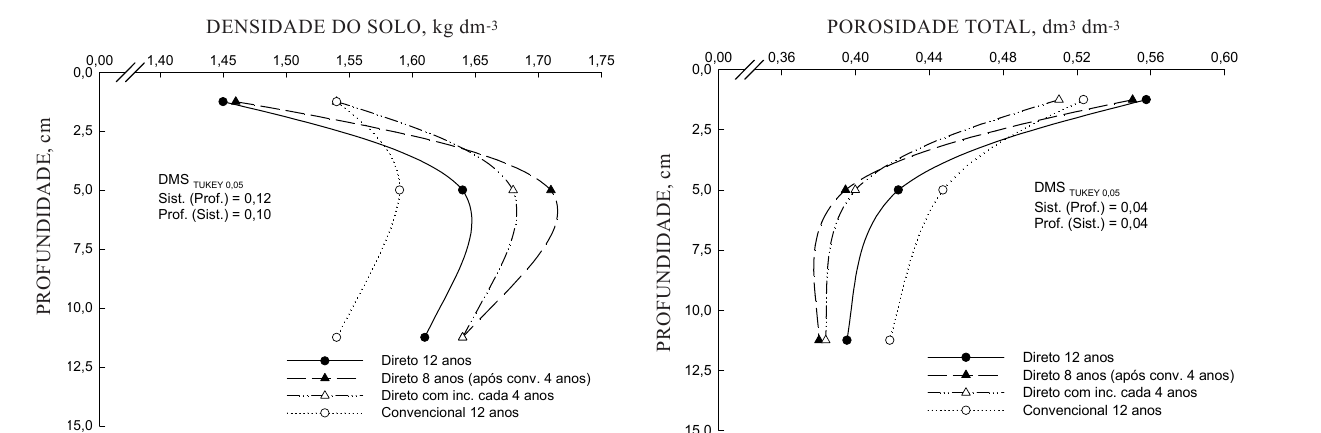
Figura 1. Densidade do solo em diferentes sistemas de manejo e profundidades.